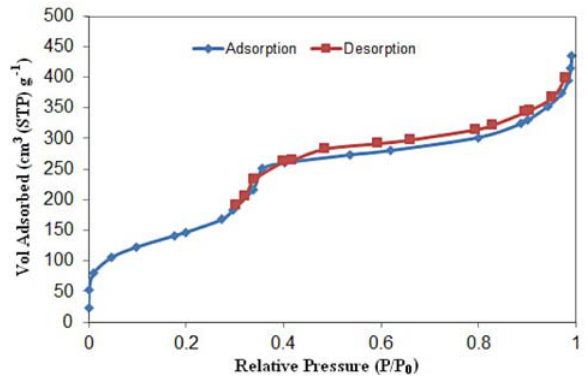
Figure 3. N adsorption–desorption isotherm of L-prol-N-pMCM- 2 41 at 77